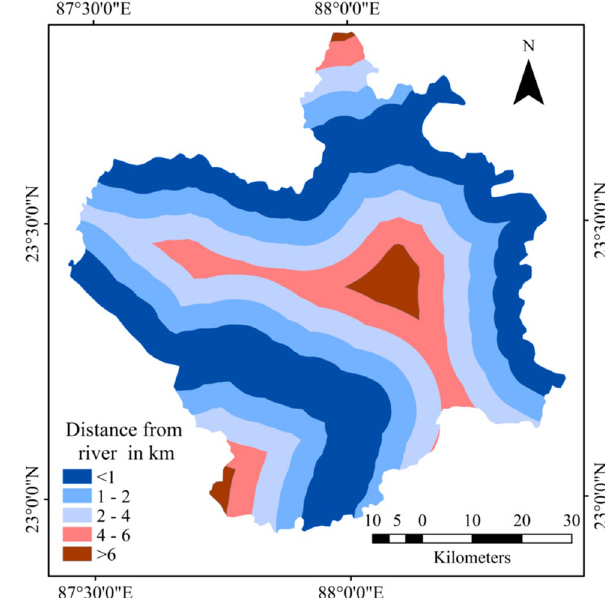
Fig. 4 Soil texture map